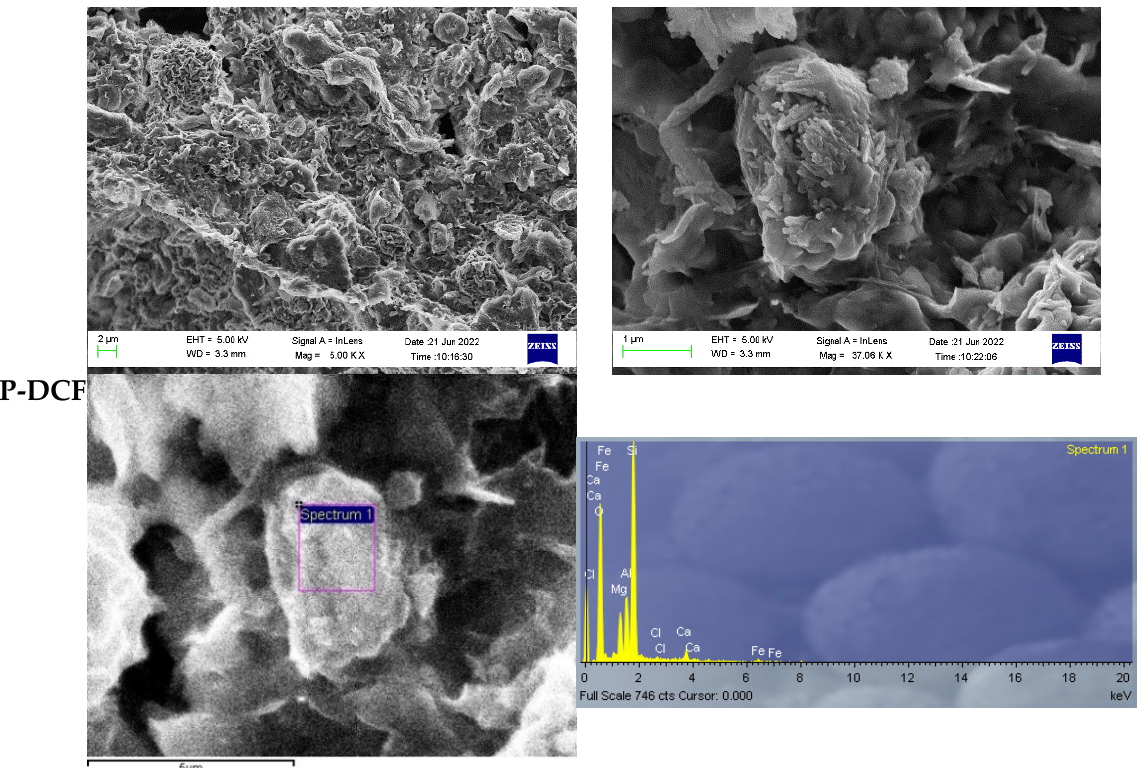
Figure 3. SEM microphotographs and EDS analysis of freeze-dried B-DCF, P-DCF, and B/P-DCF gels.